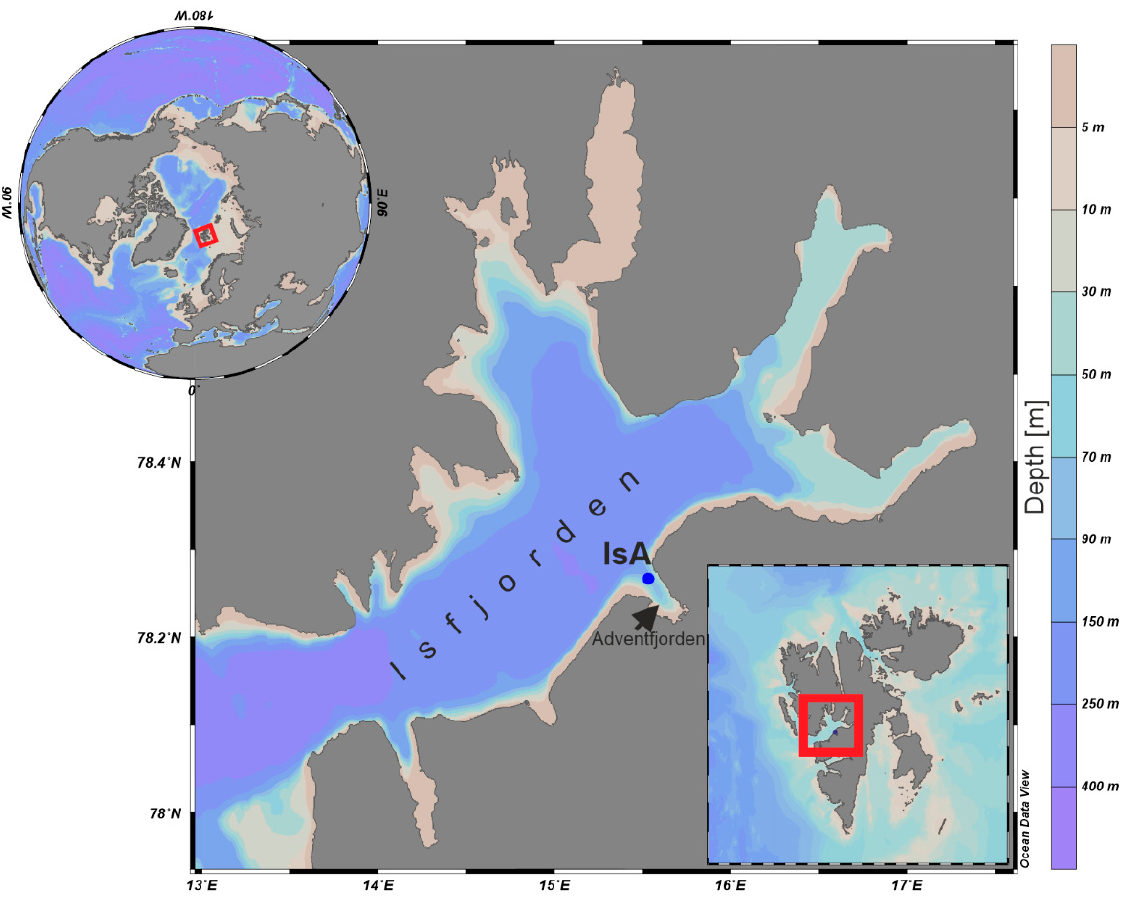
Figure 1. Water sampling site (IsA station) in Isfjorden (Svalbard). Water depth [m] for Isfjorden is indicated by the colour scale bar.